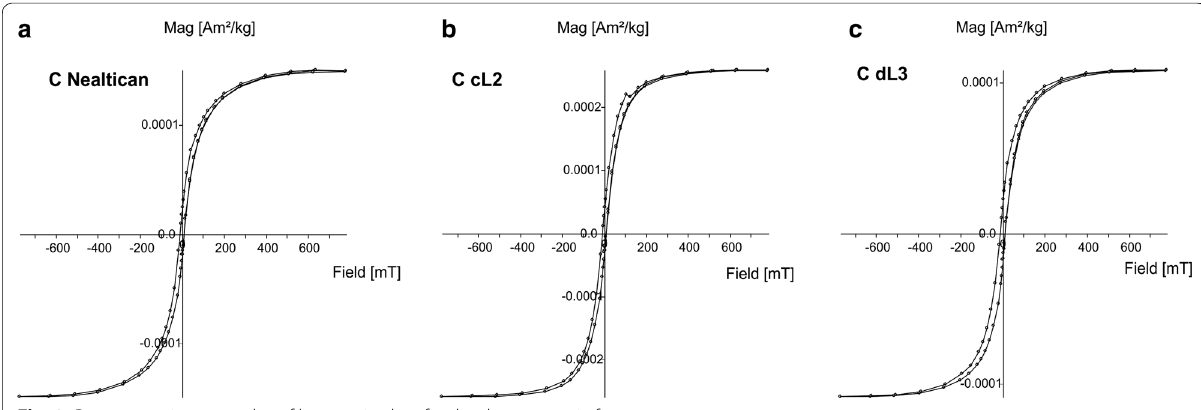
Fig. 9 Representative examples of hysteresis plots for the three ceramic